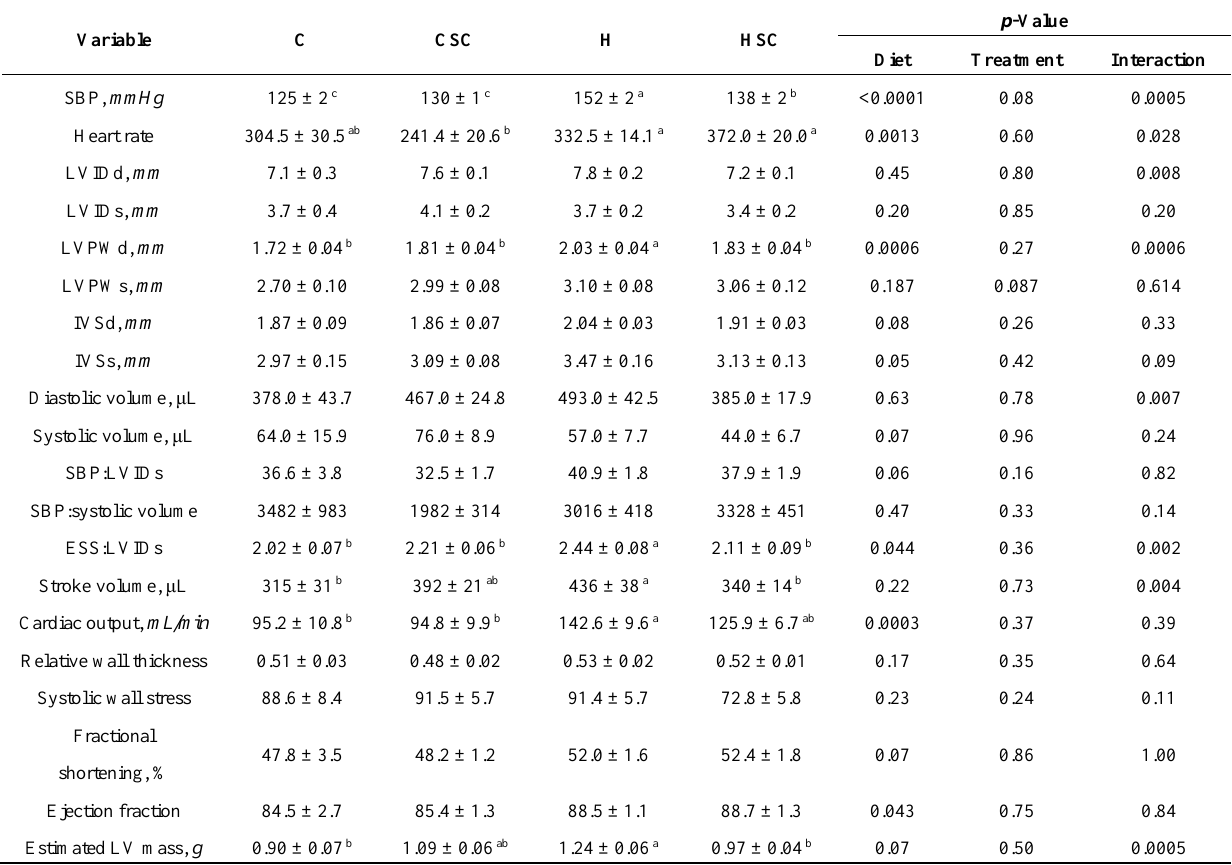
Table 3. Cardiovascular variables in C, H, CSC and HSC